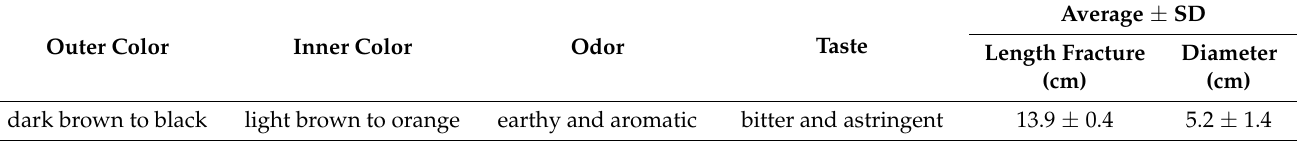
The D. villosa root cross-section (Figure 2) shows four distinct regions: the periderm, the cortex, the cambial “band” and the central cylinder (Figure 2a). The cortex is yellowish- brown, and the central cylinder is light yellow with a fine radial striation, occupying about three-quarters of the root diameter. Traces of secondary roots or mainly rounded scars from their fall may occur. Lenticels are frequently observed (Figure 2b). The periderm may be partially missing, and the inner layers, which are yellowish-brown, can be seen in these faults (Figure